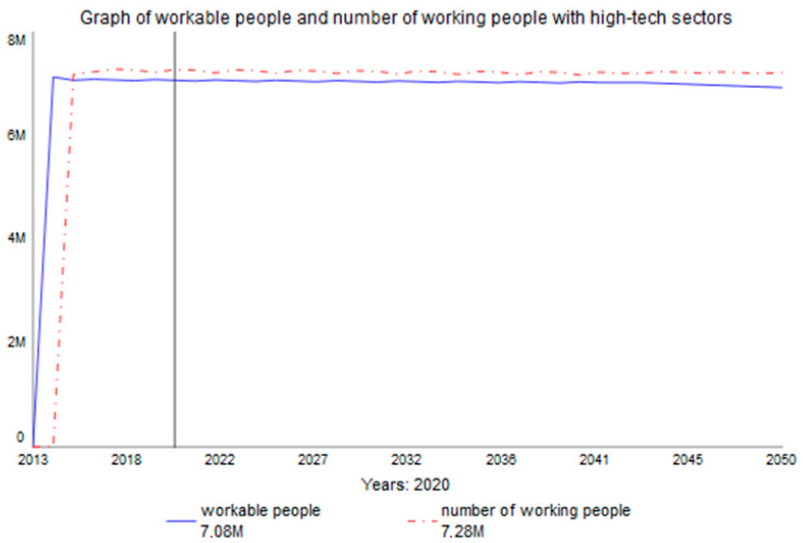
Figure 5. Economically active people and number of working people with high-tech sectors (year 2020).